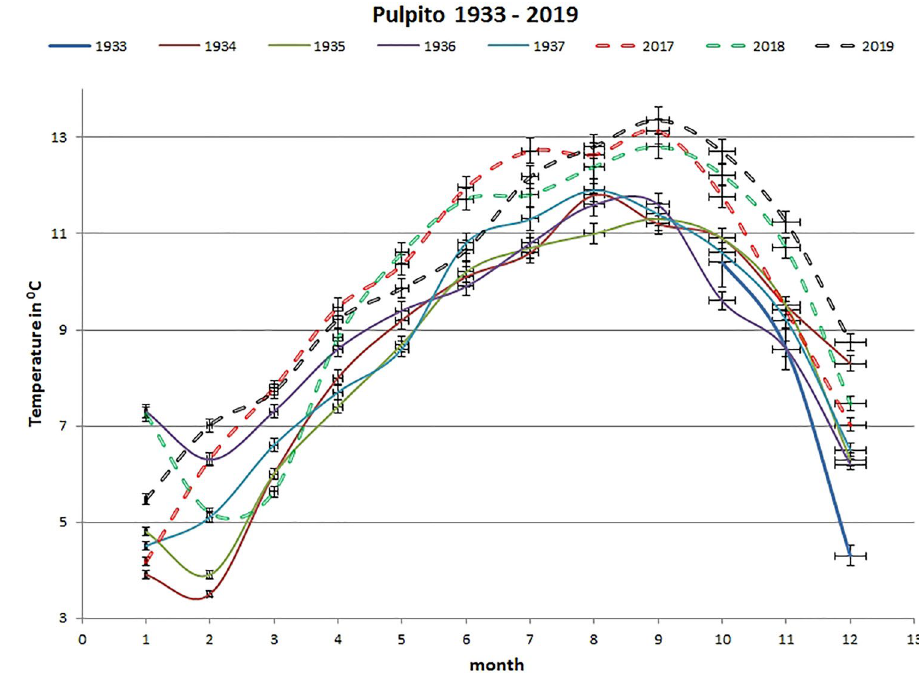
Fig. 2 Comparison of mean monthly historical [12] and current air temperatures (in °C) at the Pulpito monitoring site